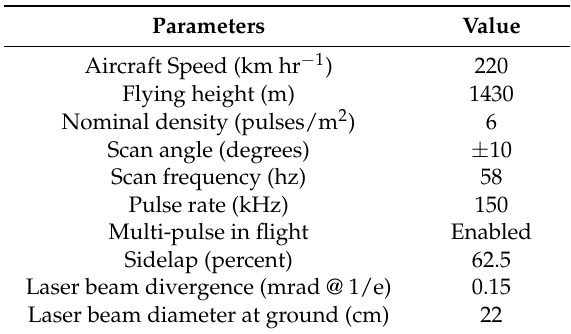
Table 2. Lidar acquisition parameters.